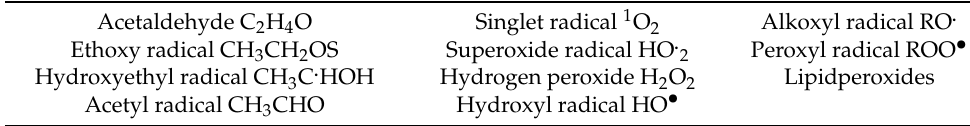
Table 1. ROS and selected potentially toxic intermediates.